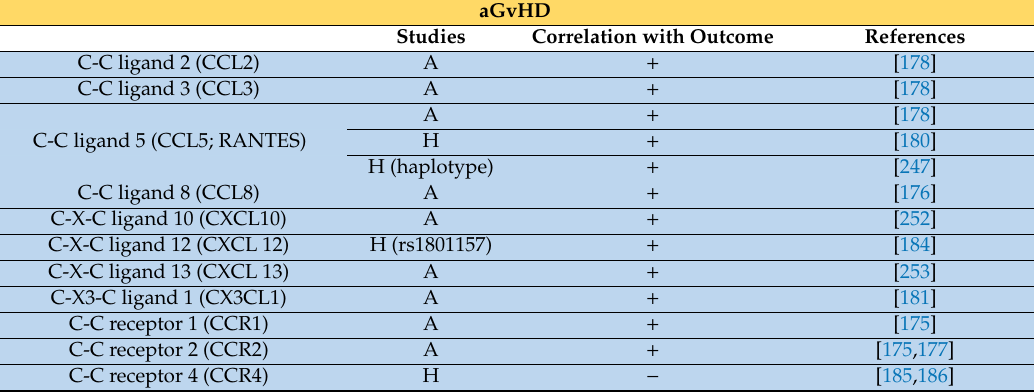
Table 3. Acute GvHD occurrence / severity in animal (A) or human (H) studies. See the Methods section regarding the reporting of results (Section